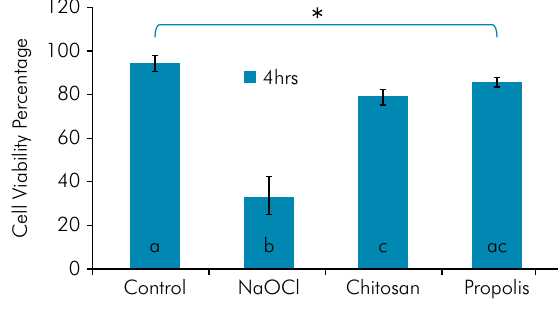
Figure 3. Changes in cell viability after 4 h exposure of groupsof solutions. Values represent mean and SD of three independent experiments. p < 0.05;* and different letters indicate statistically significant difference at 5%.